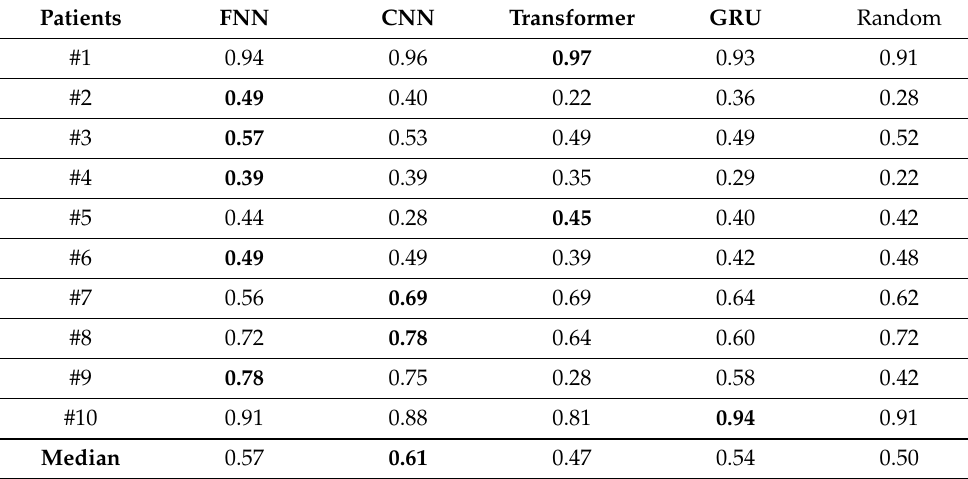
Table 7. Results for ROC-AUC (personalized scheme). 1